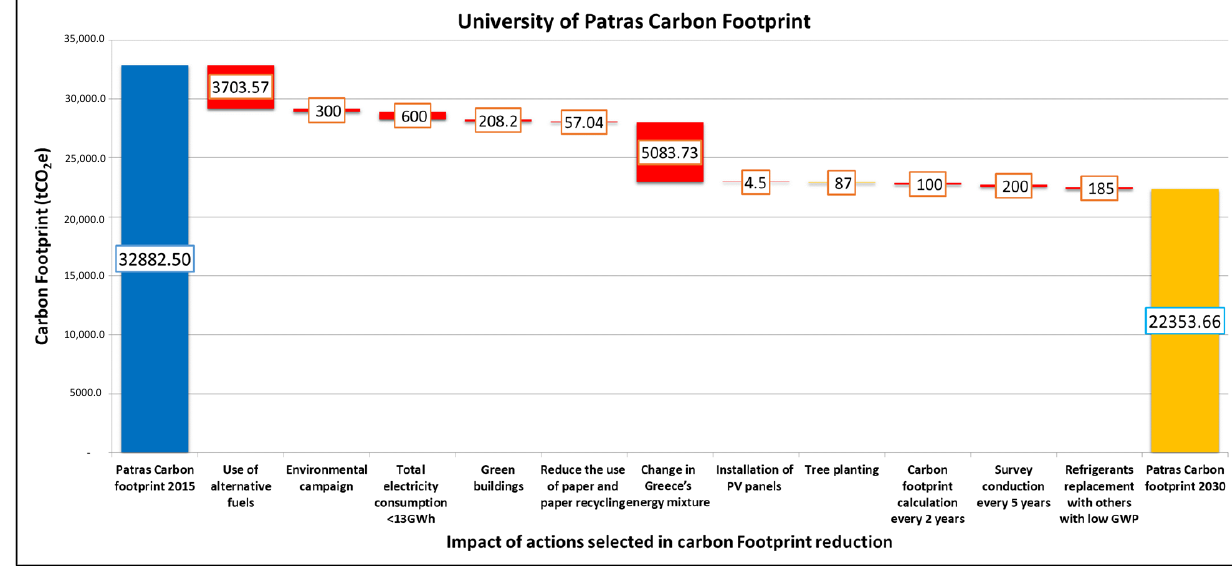
Figure 7. Waterfall diagram of the University of Patras carbon